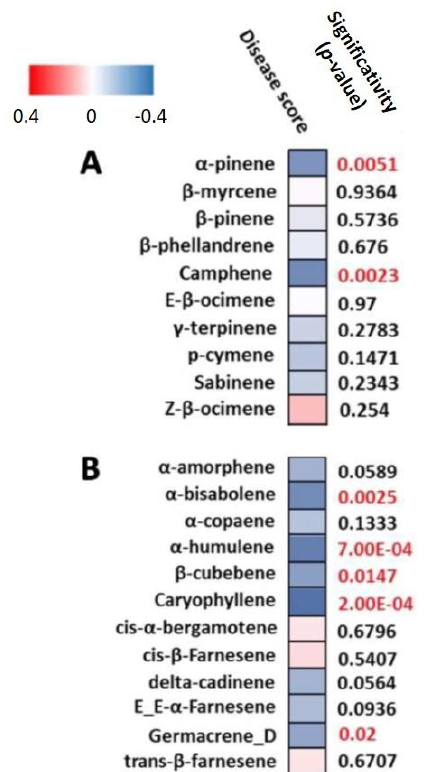
Figure 1. Spearman rank correlation between disease score and the contents of the 22 terpenes (( A ) monoterpenes; ( B ) sesquiterpenes) that mQTL co-localized with rQTL. Red square indicates positive correlation and blue, negative correlation (i.e., the higher levels of these terpenes the lower the symptoms). Significance of correlation is given by the p -value. Red labels indicate p -values < 0.05. mQTL associated with these seven terpenes co-localized with rQTL on chr 1, 4, 6 and 8 (Figure 2). For mQTL on chr 1, 4 and 6, favorable alleles for their accumulation and favorable alleles for resistance underlying the rQTL were brought by K3. For rQTLs on chr 8, H1 brought the favorable allele for resistance and the favorable alleles for terpene accumulation (α -humulene, caryophyllene and germacrene D). Metabolite accumulation explained by the mQTL (global R 2 ) ranged between 12% (for α -humulene) and 58% (for α -pinene and camphen e) (Table 1). The heritability varied from 31% (β -cubebene) to 65 and 68% for camphene and α -pinene, respectively. Camphene and α -pinene exhibited the same max position for their respective two mQTL on chr4 with approximately the same R 2 . These two metabolites shared the same max position with caryophyllene at the bottom of the chr 4. Germacrene D and β -cubebene also had the same max position on chr 1 and